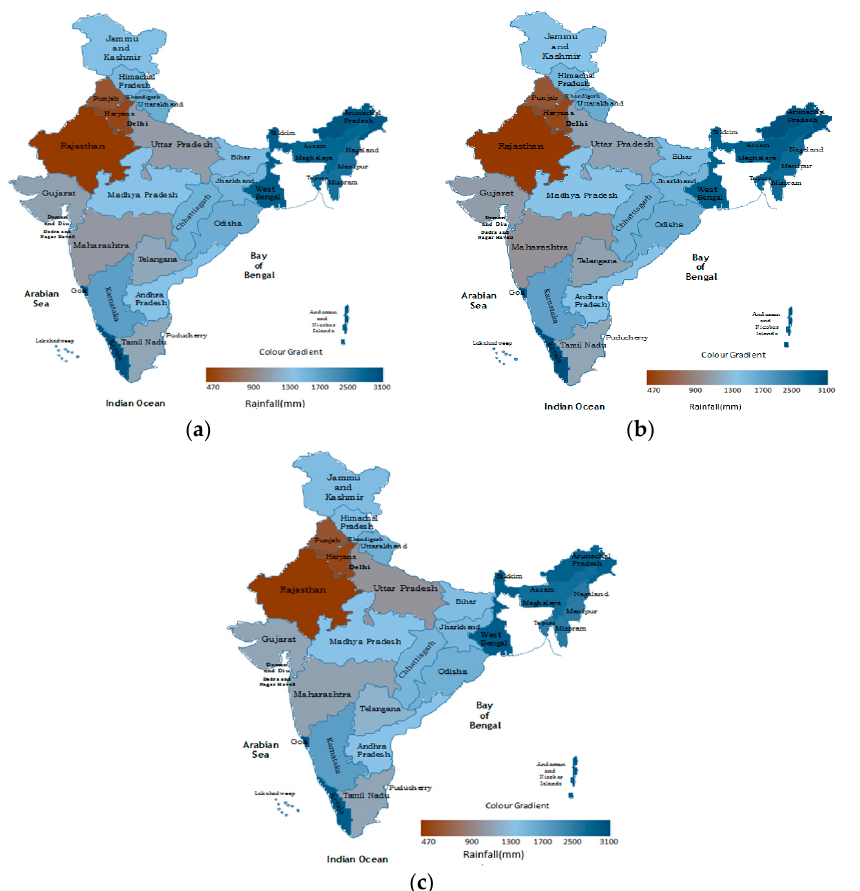
Figure 3. Average annual rainfall of different regions in India for specific duration: ( a ) 1901–2017, ( b ) 1901–1967, ( c ) 1968–2017 (Source for template: https://indzara.com/wp-content/up-